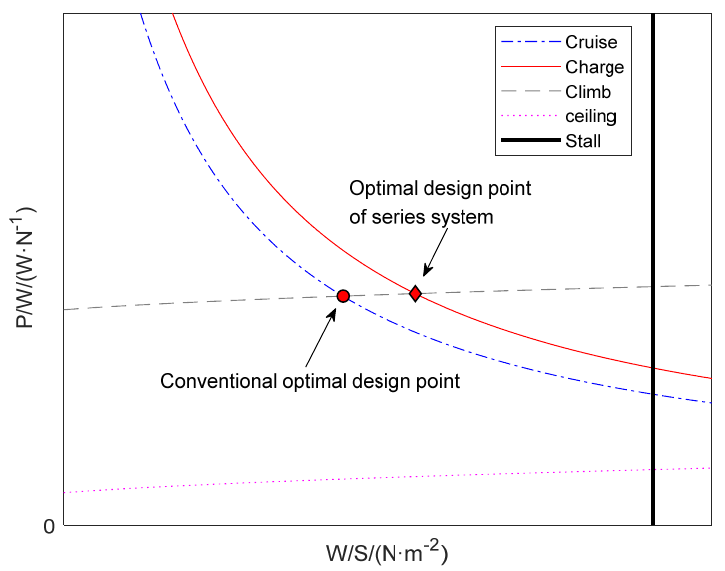
Figure 4. Design space of point performance constraints in fixed-wing mode.